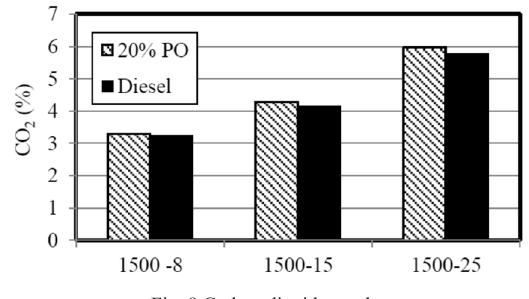
Fig. 8.Carbon dioxide